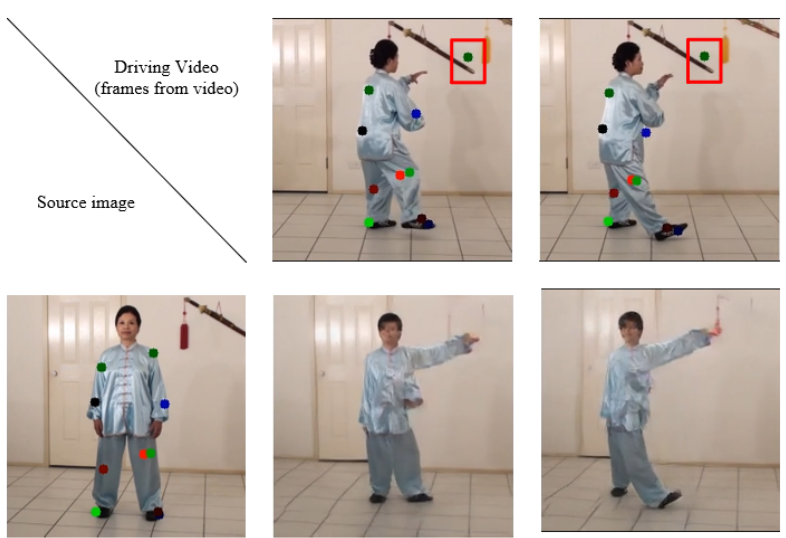
Figure 2. Failure cases of FOMM. ( a ) Frame 1 generated with the incorrect posture. ( b ) Frame 2 generated with the incorrect posture. ( c )Frame 1 generated with ghost effects. ( d ) Frame 2 gener- ated with ghost effects.